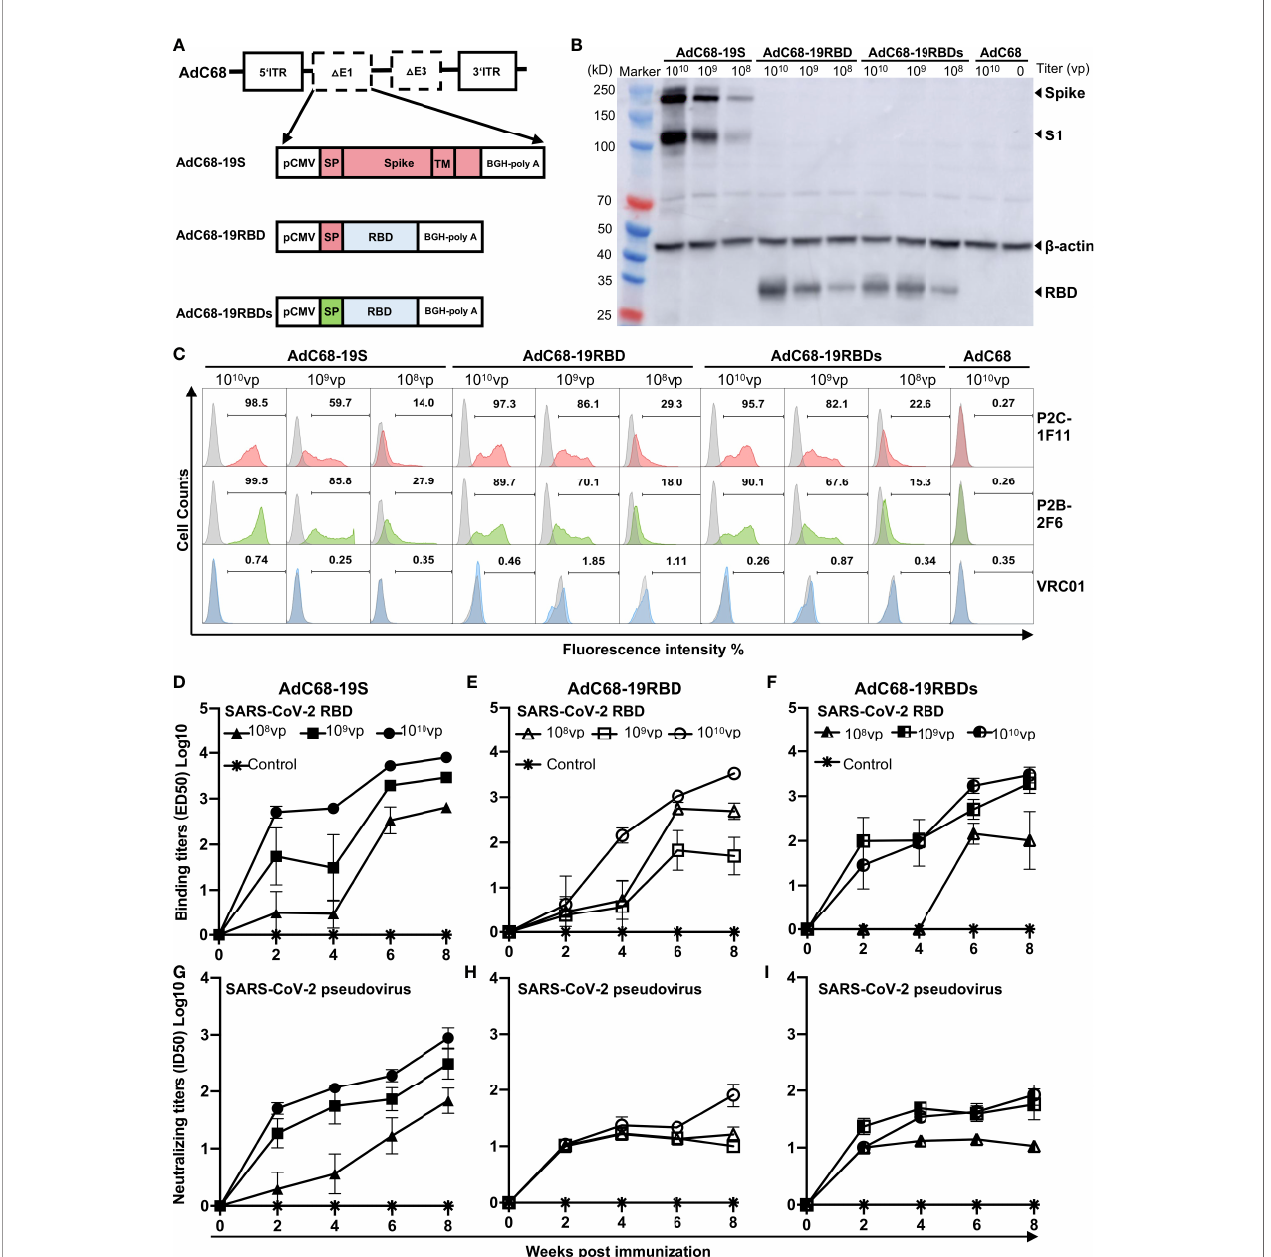
FIGURE 1 | Generation and characterization of recombinant AdC68 expressing the full-length spike protein or RBD of SARS-CoV-2. (A) Schematic diagram of the recombinant AdC68 expressing the full-length S protein with its original signal peptide (AdC68-19S), RBD with the original signal peptide from the S protein (AdC68- 19RBD), or RBD with the secretory signal peptide from mouse IgG (AdC68-19RBDs). The coding sequence of the S protein or RBD was inserted into the E1 region of the AdC68 vector under the control of the CMV promoter and terminated using a bovine growth hormone (BGH) polyadenylation signal sequence. (B) Western blot analysis of S and RBD expression in HEK293T cells infected with the recombinant AdC68 (10 8 , 10 9 and 10 10 vp). (C) Flow cytometry analysis of S and RBD expression using the SARS-CoV-2-speci fi c mAbs P2C-1F11 and P2B-2F6. HEK293T cell lysates and intact HEK293T cells infected with the empty AdC68 vector (10 10 vp) were used as negative controls. VRC01 was used as a negative control antibody. BALB/c mice (n = 5 per group) were immunized by three vaccines respectively. The empty AdC68 was used as a control vaccine. Serum binding activity of total IgG to SARS-CoV-2 RBD (D – F) and neutralizing activity against pseudotyped SARS-CoV-2 (G – I) over an 8-week period after single-dose immunization with AdC68-19S, AdC68-19RBD, or AdC68-19RBDs. For each recombinant AdC68 construct, three different doses (10 10 , 10 9 , and 10 8 vp) were administrated through IM route, which is indicated by different symbols. Data points corresponding to animals in the empty AdC68 vector control groups (10 10 vp) are shown with asterisk. All data are presented as means ±